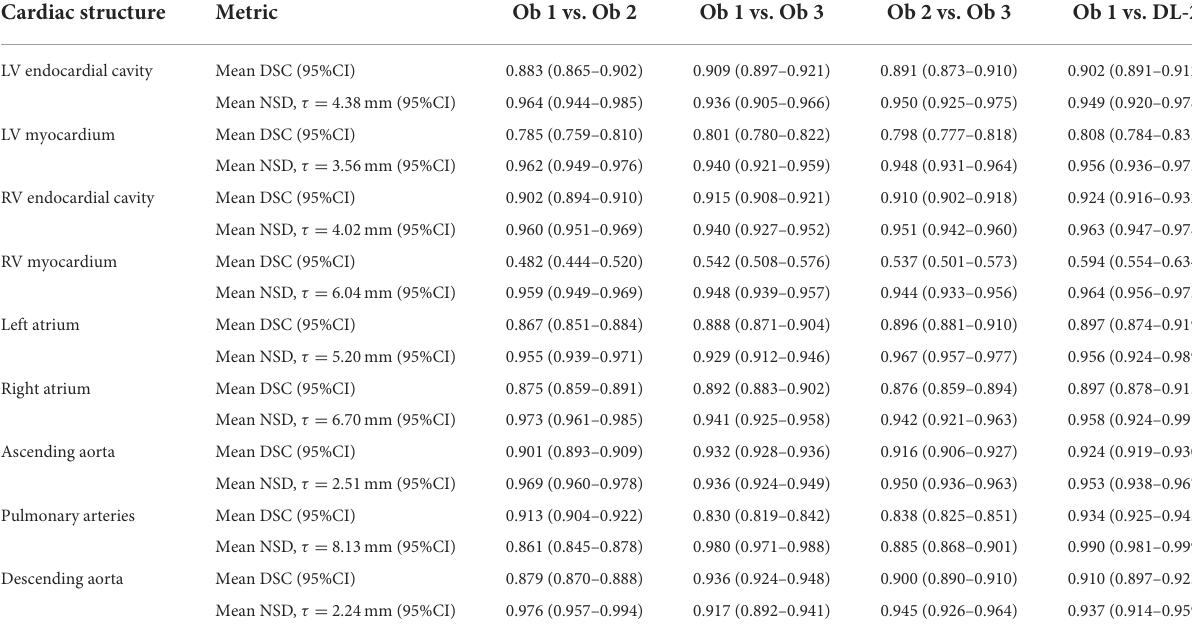
TABLE 2 Dice similarity coefficients (DSC) and normalised surface distances (NSD) for the three observers and DL model 2 evaluated in the interobserver comparison cohort ( n = 24). Cardiac